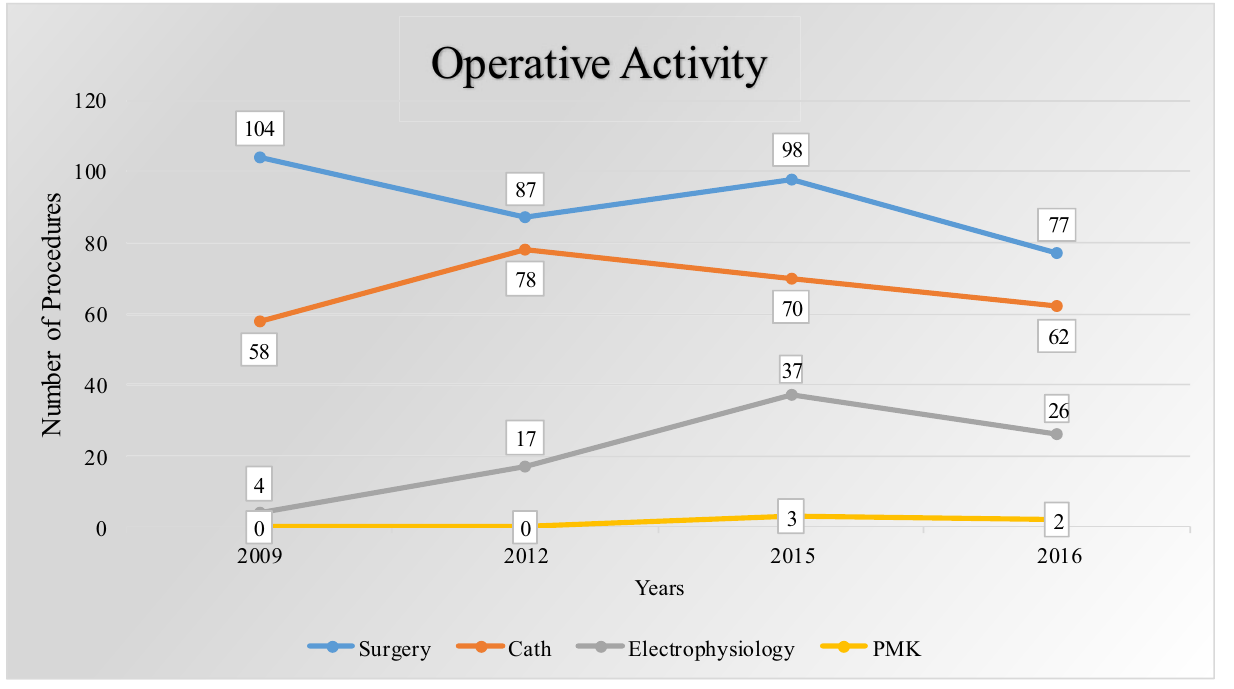
Surgery Cath PMK The blue curve correspond to the number of surgeries. Similarly, the gray line indicates the electrophysiology activities. Frontiers in Pediatrics |